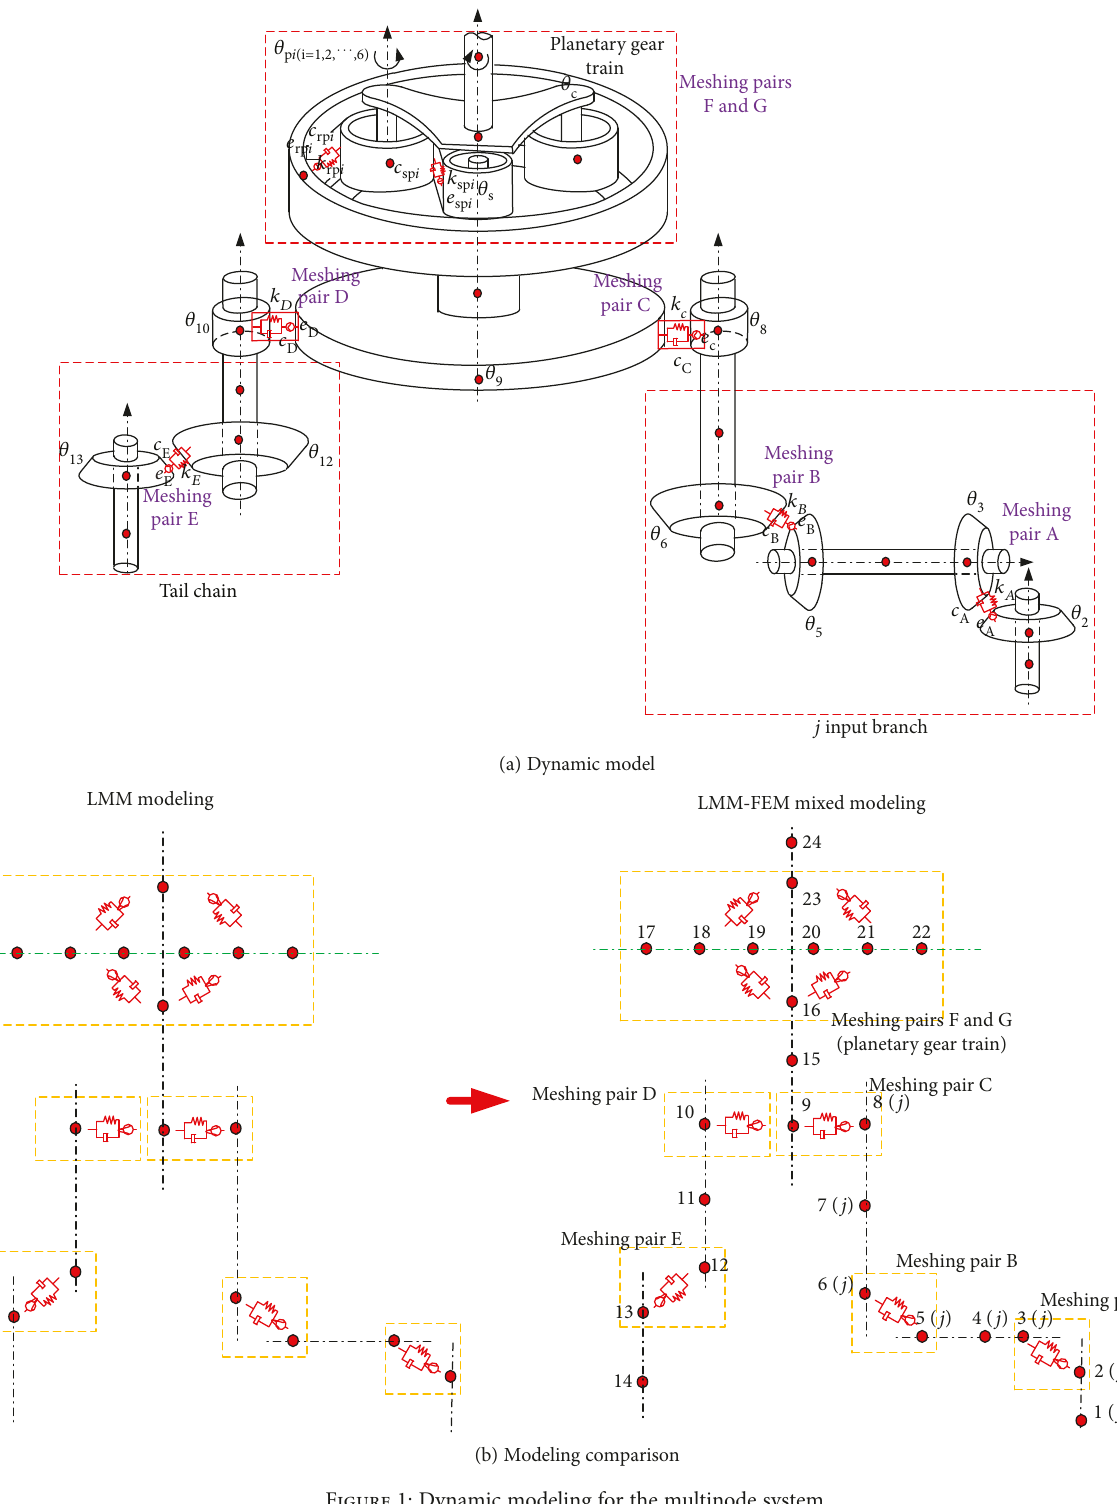
Figure 1: Dynamic modeling for the multinode